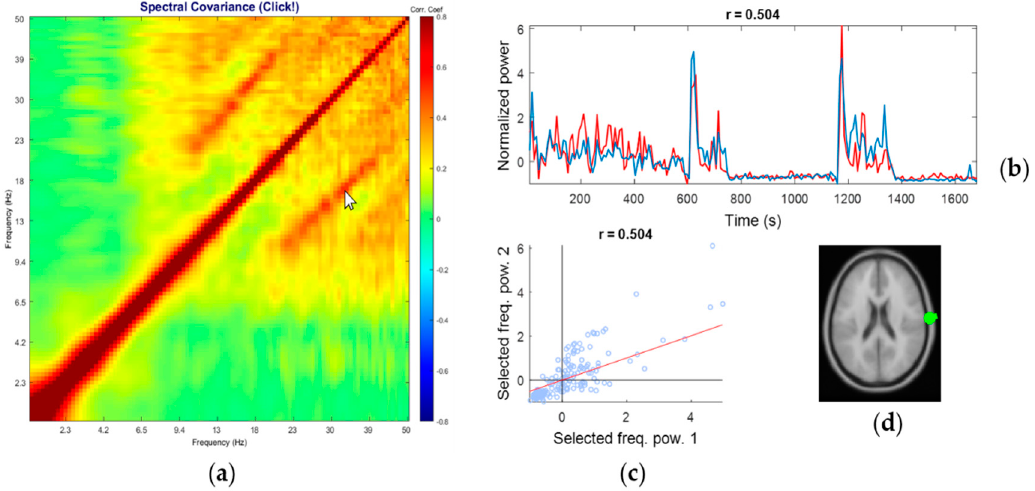
Figure 5. A representative comodulogram of Muscle-Class (Subject 3, IC No. 16): ( a ) the comodulogram; ( b ) time series of the cross-frequency PPC of the combinations of the selected frequency bins specified by the cursor position on the comodulogram; the currently selected pair is 16.0 Hz and 32.6 Hz, and their correlation coe ffi cient is 0.504; ( c ) the scatter plot of PSD from individual windows of the selected pair; ( d ) the corresponding equivalent current dipole model localized at (72, − 10, − 6) in Talairach coordinates, which identified as muscle artifact. Note the broadband second harmonics as a parallel line between 10 and 20 Hz coupled with 20–40 Hz.